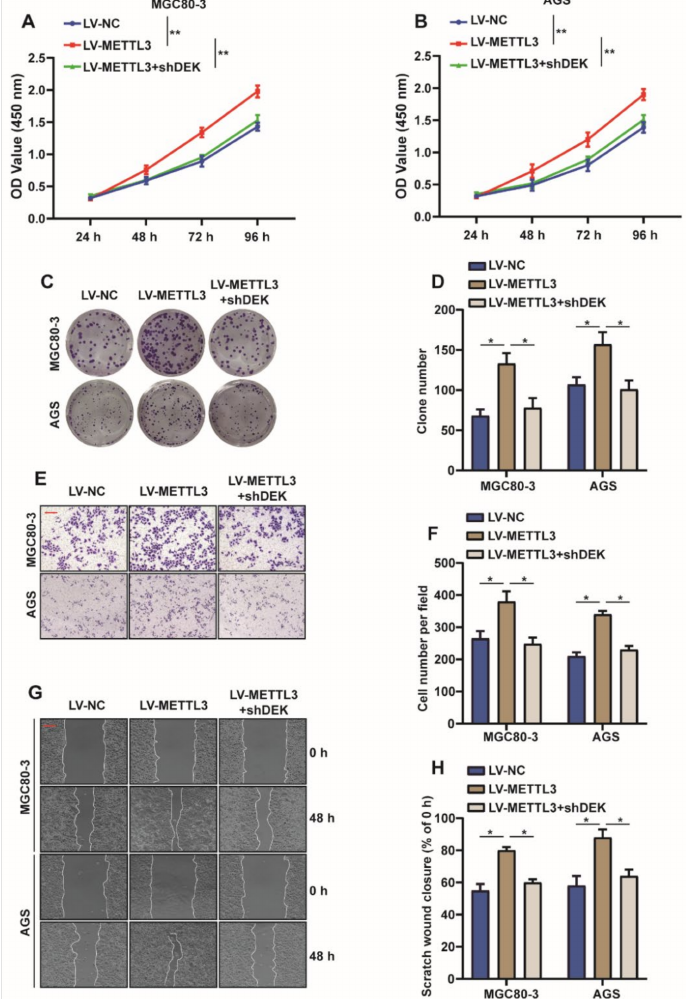
Figure 5. METTL3 promotes proliferation and migration of GC cells by regulating DEK. ( A , B ) Overexpression of METTL3 in MGC80-3 and AGS cells increased cell viability, and knock- down of DEK when METTL3 was overexpressed reversed the effect of METTL3 on cell viability ( n = 3, **: p < 0.01). ( C , D ) Overexpression of METTL3 in MGC80-3 and AGS cells promotes cell clone formation, and knockdown of DEK when METTL3 is overexpressed reverses the effect of METTL3 on clone formation ( n = 3, *: p < 0.05). ( E , F ) Overexpression of METTL3 in MGC80-3 and AGS cells promotion of METTL3 on cell migration ( n = 3, *: p < 0.05). ( G , H ) Overexpression of METTL3 in MGC80-3 and AGS cells promotes cellular wound healing, and knockdown of DEK when METTL3 is overexpressed reverses the effect of METTL3 on cellular wound healing ( n = 3, *: p <